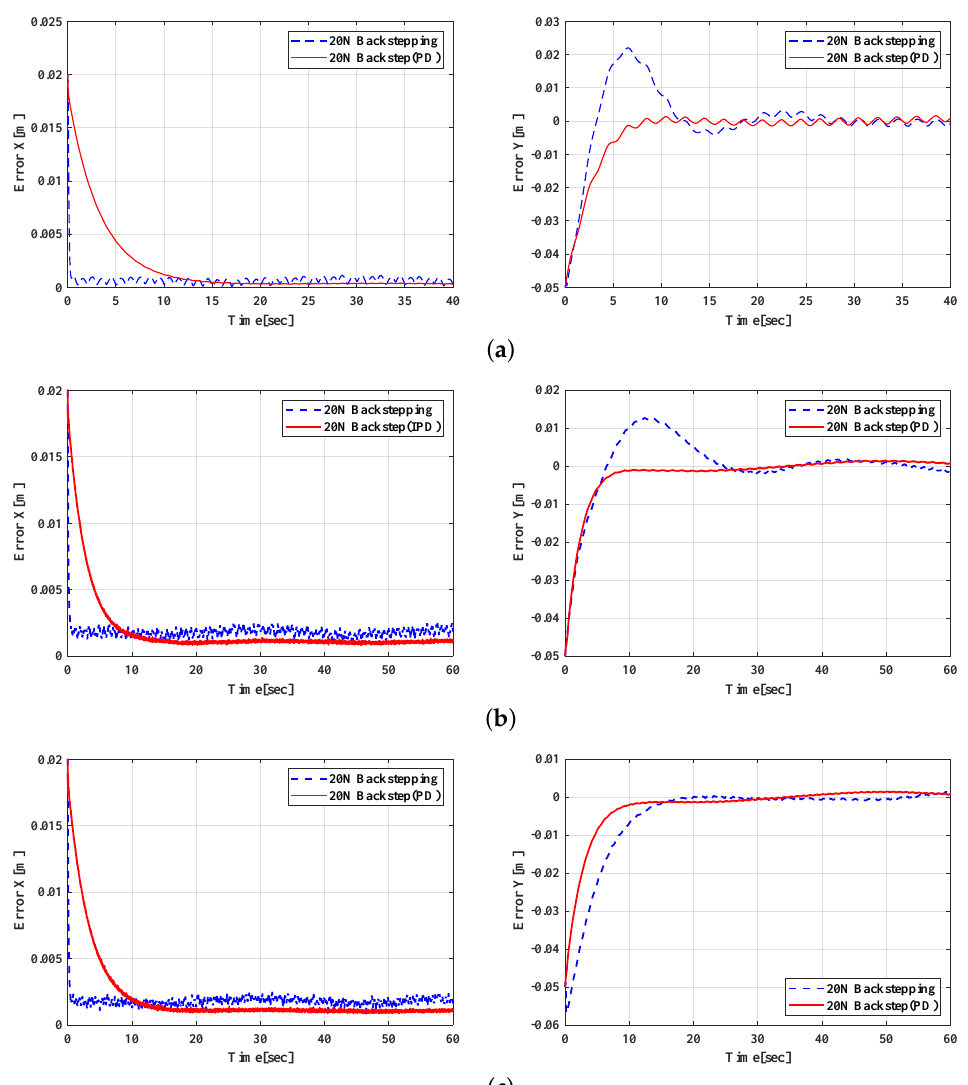
Figure 11. Position errors with reciprocal motion of the upper arm. ( a ) Period = 2.0 s; ( b ) Period = 1.5 s; ( c ) Period = 1.0